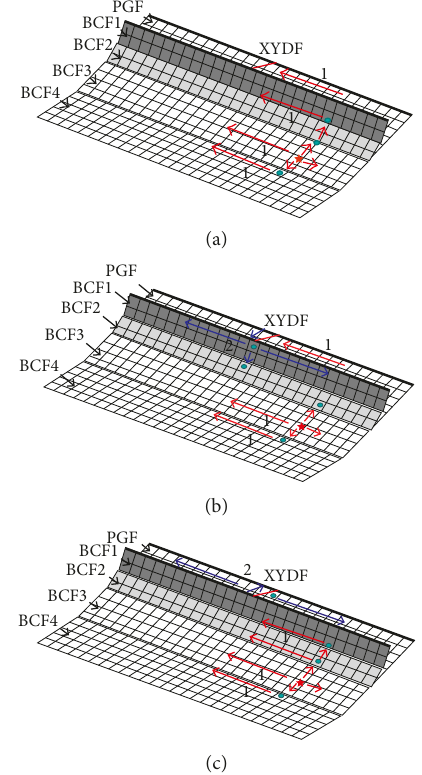
Figure 5: Three rupture sequences for the Wenchuan earthquake: (a), (b),and(c)refertorupturesequences1,2,and3,whilethecirclesdenote the earliest rupture subfaults, and the arrows denote rupture